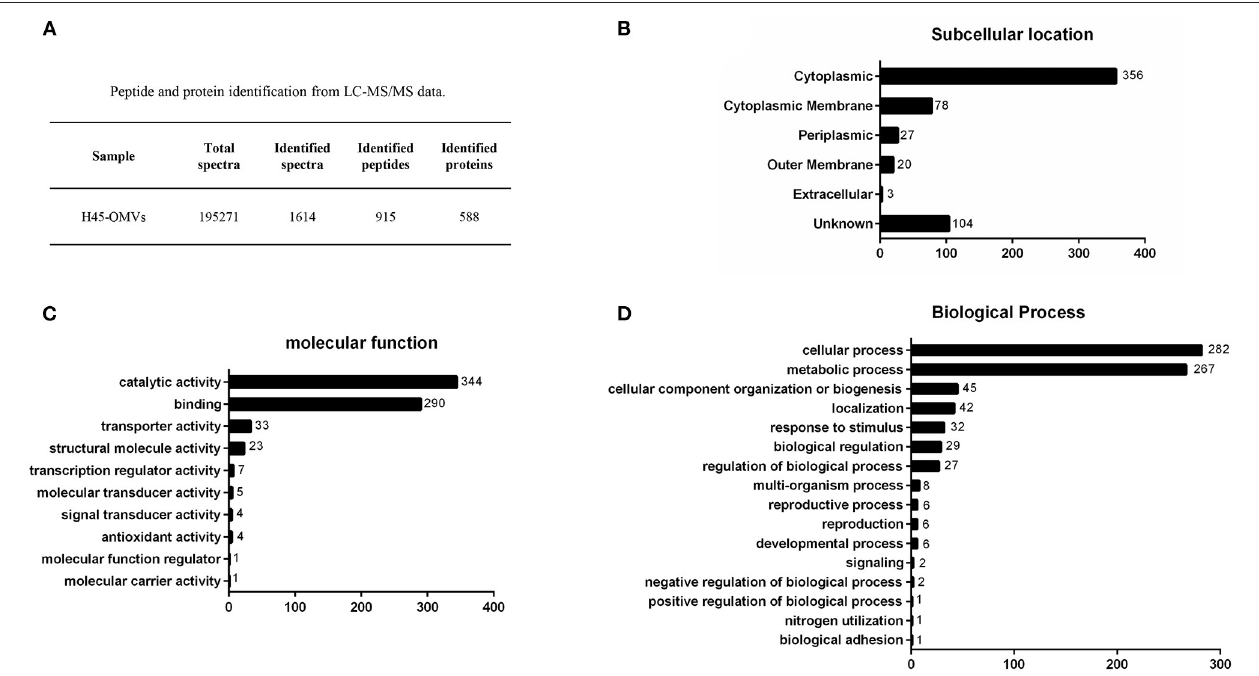
FIGURE 3 | Overview of proteome identification of H45 -derived OMVs. (A) Peptide and protein of OMVs from liquid chromatography with tandem mass spectrometry data. (B–D) All identified proteins of H45-OMVs were analyzed by GO functional annotation (http://www.geneontology.org.), subcellular location (B) , molecular function (C) , and biological process of genes (D)